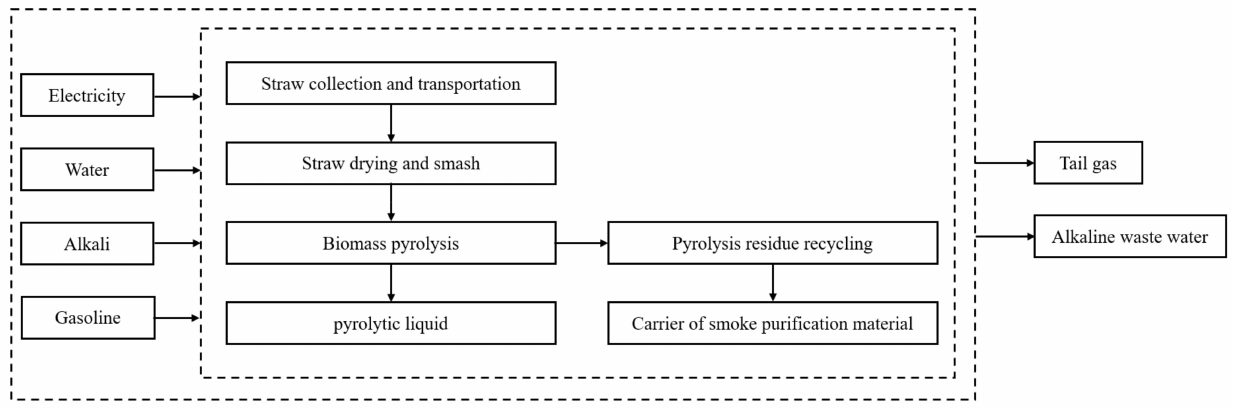
Figure 2. Lifecycle assessment system boundary of the non-phase-transition drying pyrolysis and mass conversion